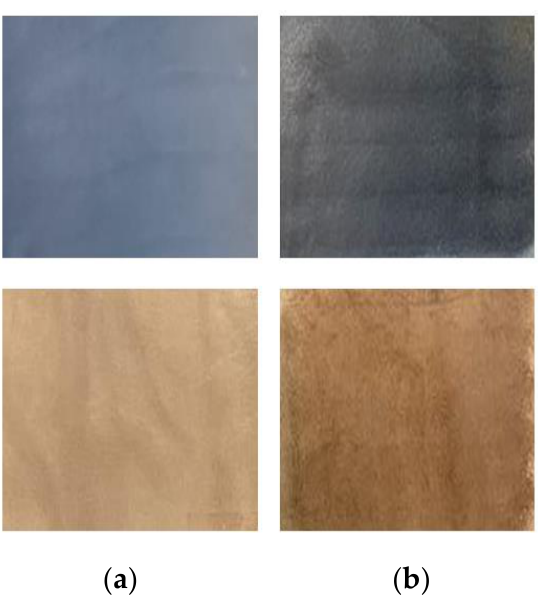
Figure 19. Leather before and after polishing obtained with the planetary motion and a backing pad of 30 mm diameter: ( a ) Leather before polishing; ( b ) 60 mm × 60 mm area of polished leather.